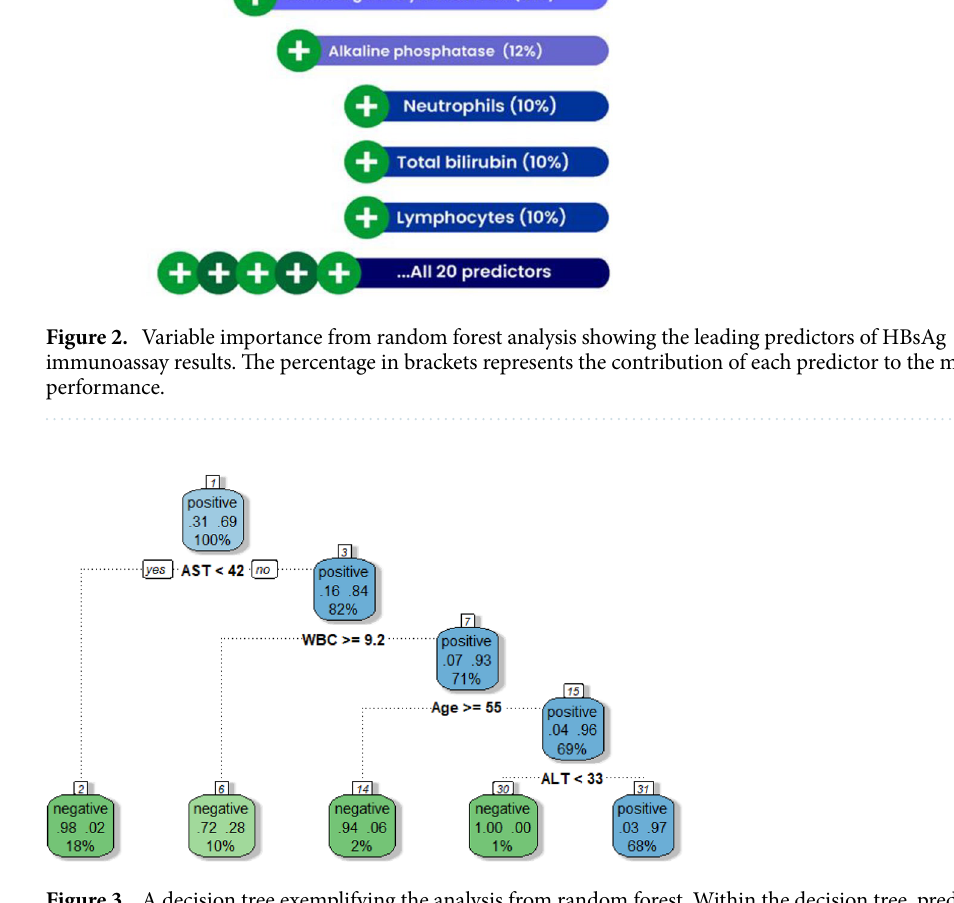
Figure 3. A decision tree exemplifying the analysis from random forest. Within the decision tree, predictor variable thresholds are calculated to formulate rules to guide HBsAg positive or negative prediction.